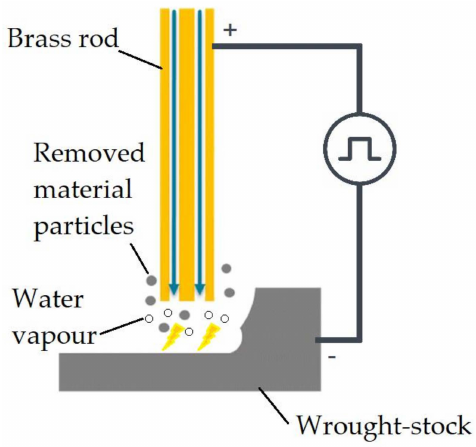
Figure 13. Schematic representation of the EDM experiment setup (adapted from [96]).